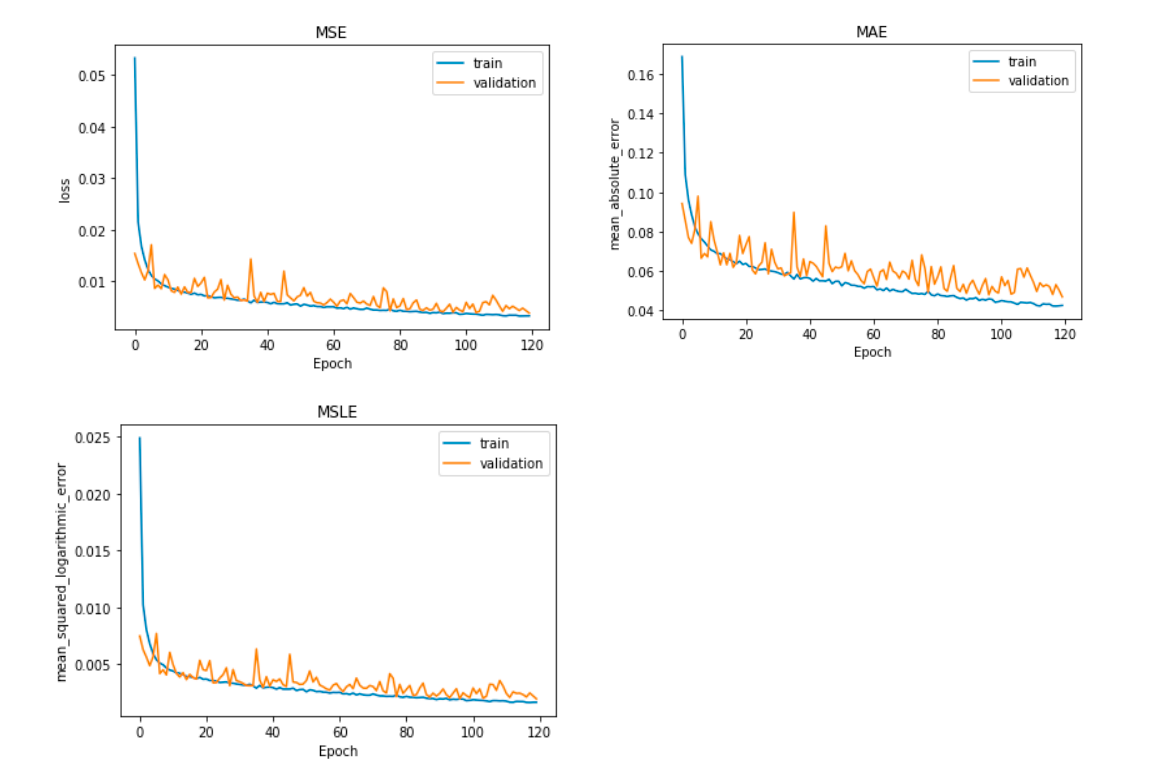
Figure 5. Multiple inverters and model predictions with the same A-11 feature variable information (SimpleRNN) .